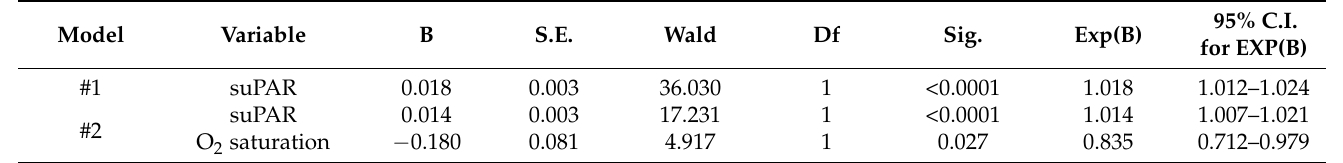
Table 4. Binary logistic regression analysis for mortality (dependent variable) during the three months of follow-up and laboratory markers (explanatory variables).